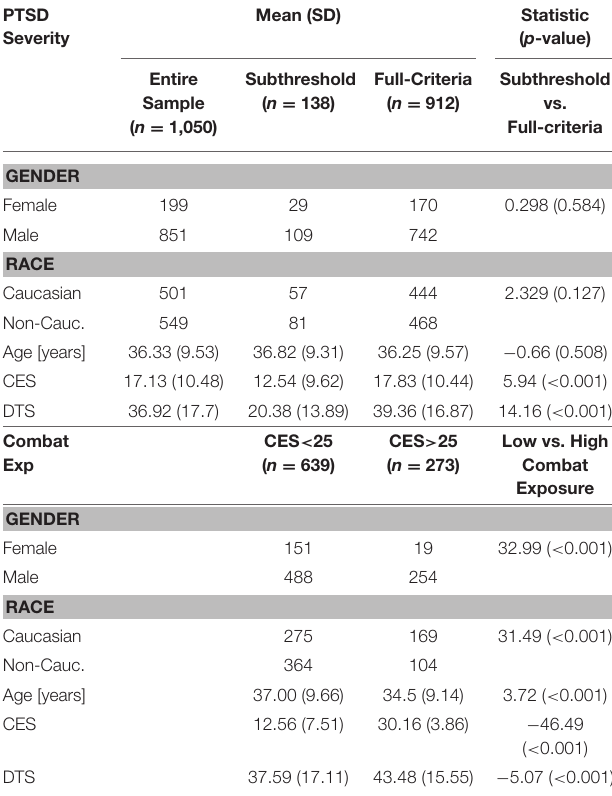
TABLE 1 | Demographics for PTSD severity comparison between veterans meeting full criteria and subthreshold (top) and combat exposure comparison between high and low combat exposure